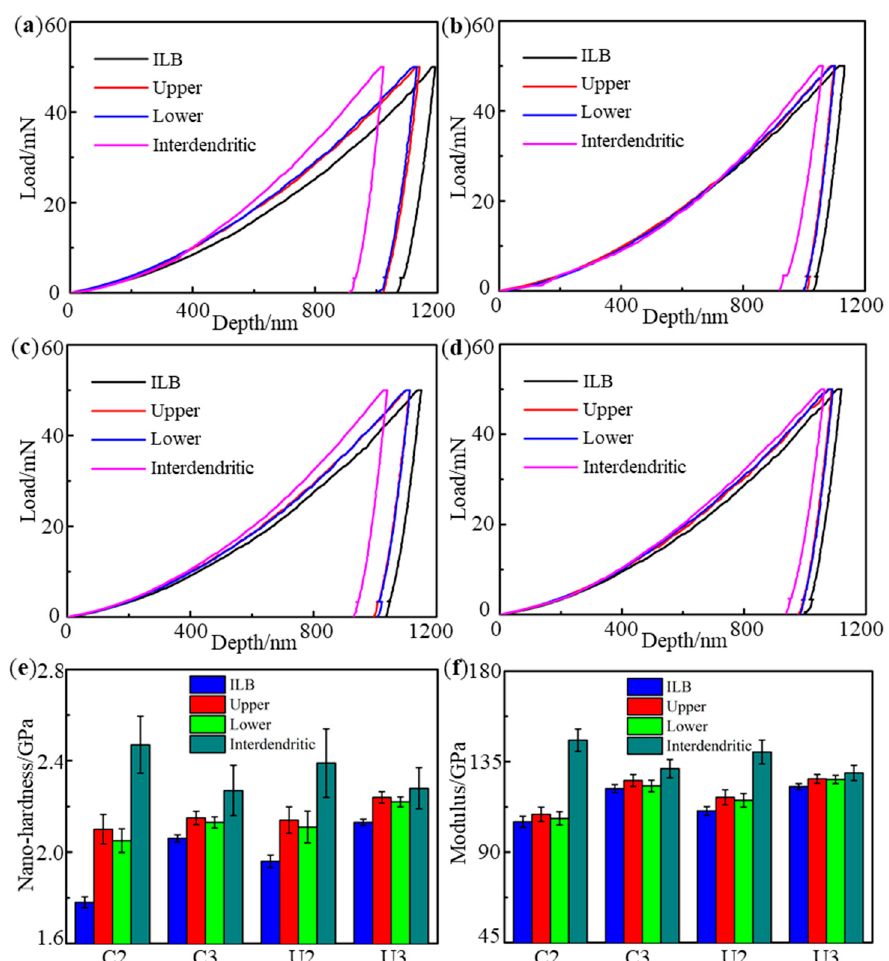
Figure 14. ( a – d ) Load-depth curves of C2, C3, U2 and U3, respectively, ( e ) nanohardness of C2, C3, U2 and U3, respectively, ( f ) modulus of C2, C3, U2 and U3, respectively.